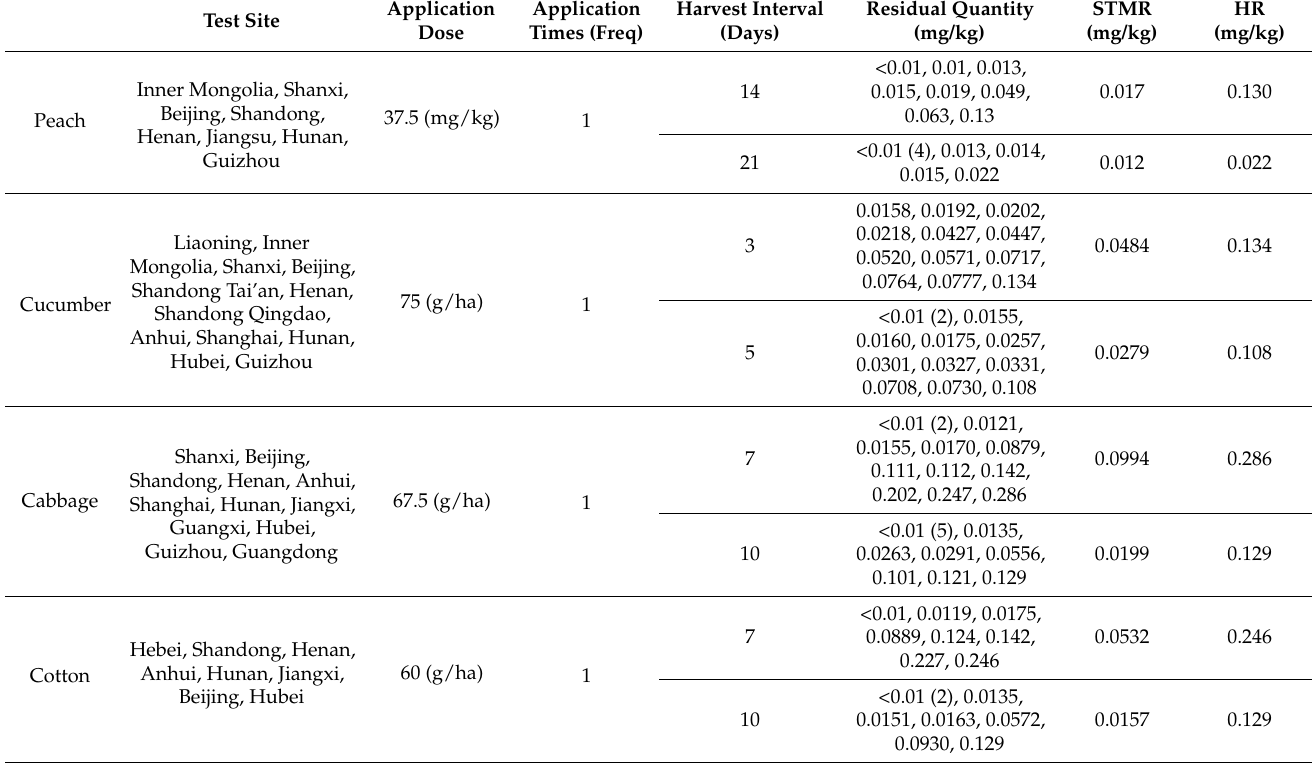
Table 4. Terminal residues of flonicamid in four